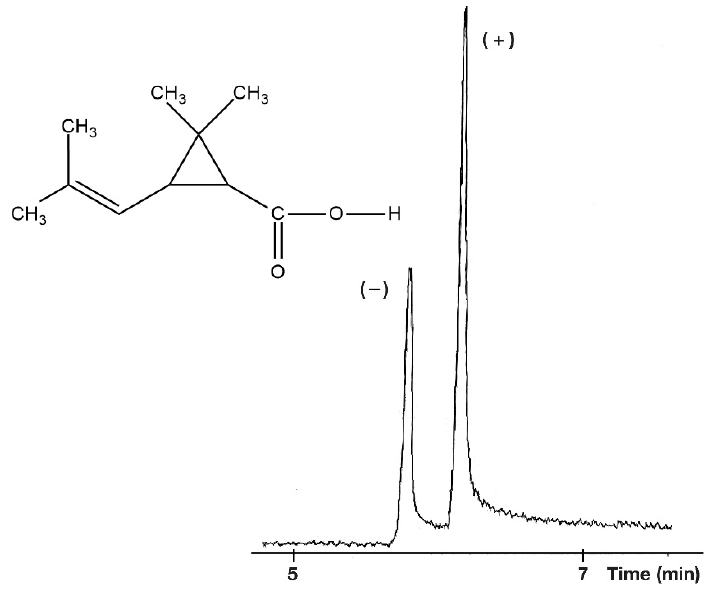
Figure 8. Separation of trans ‐ chrysanthemic acid enantiomers with permethyl γ‐ CD selector. Conditions: instrument, Shimadzu GC/MS ‐ QP5000 GC/MS; column, 25 m × 0.22 mm; stationary phase, Gamma Dex 120 (0.25 μ m); carrier, He (50 cm/s); temperature, 150 °C.